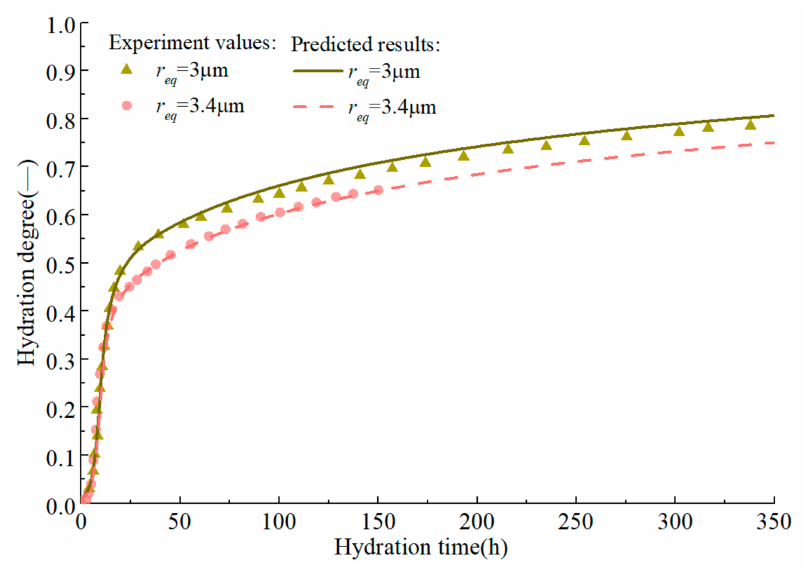
Figure 9. Experimental values and prediction curves of hydration degree of pure C 3 S in middle